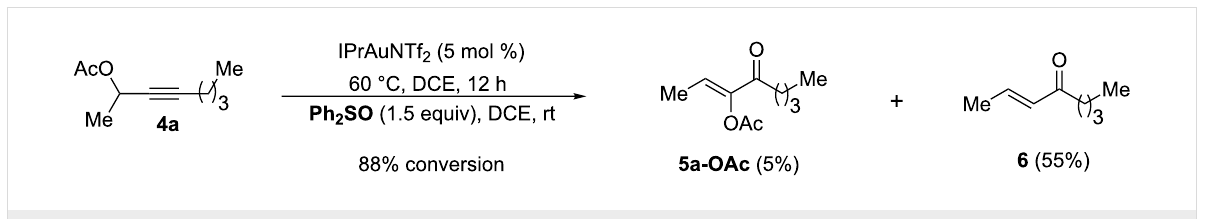
Scheme 4: A drastically different outcome by using diphenyl sulfoxide as the oxidant.